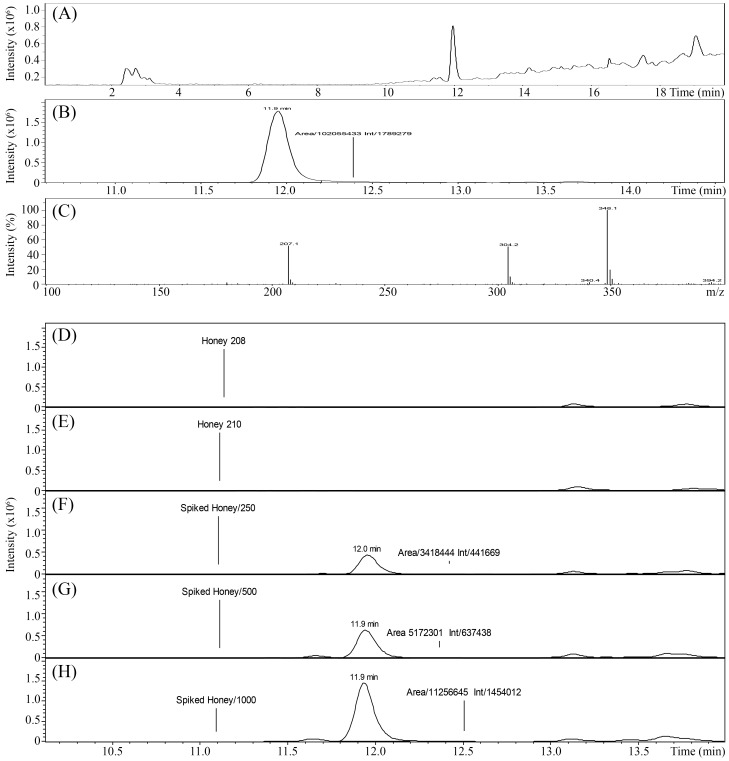
Total Ion Current (TIC) and MS full-scan analysis of ampicillin standard obtained from LC/ESI/MS in negative mode.The m/z 348.1 eluting at RT 11.9 min was used for quantitation of antibiotic traces in honeys H208 and H210. Honey H208 spiked with amplicillin at 250 ng, ml, 500 ng/ml and 1000 ng/ml served as internal standards.